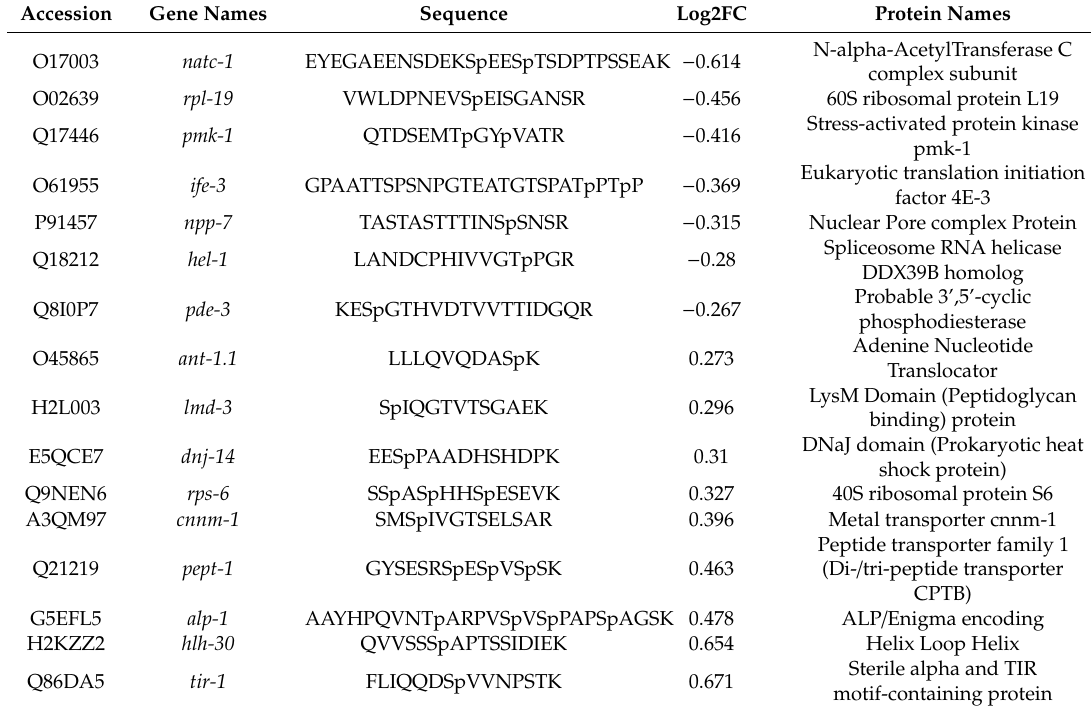
Table 1. The aging-related phosphoproteins in C. elegans at low temperatures.